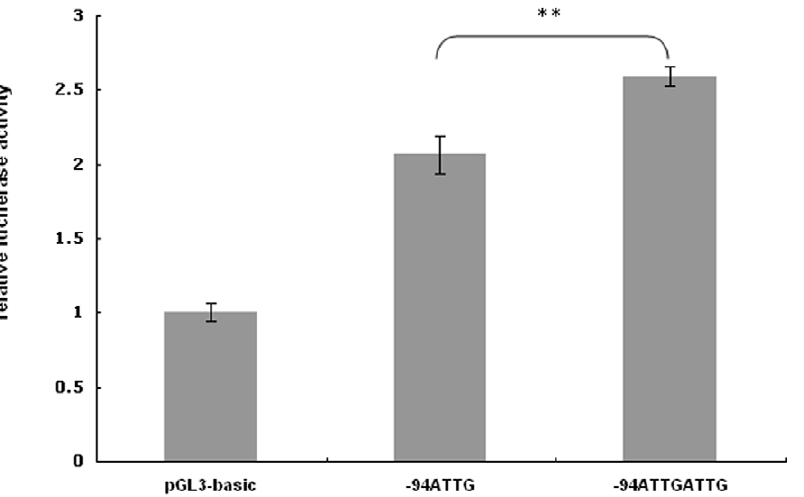
Figure 4. Reporter assay of rs28362491 (-94ins/delATTG) of NFKB1 in SH-SY5Y cells. pGL3 luciferase reporter contained either the - 94ATTGATTG (W) or the -94ATTG (D) allele at the promoter region of the NFKB1 . Values represented the average of three experiments and the error bars represented the standard deviation. pGL3-basic was used as control without any promoter sequence inserted. ** P , 0.01.